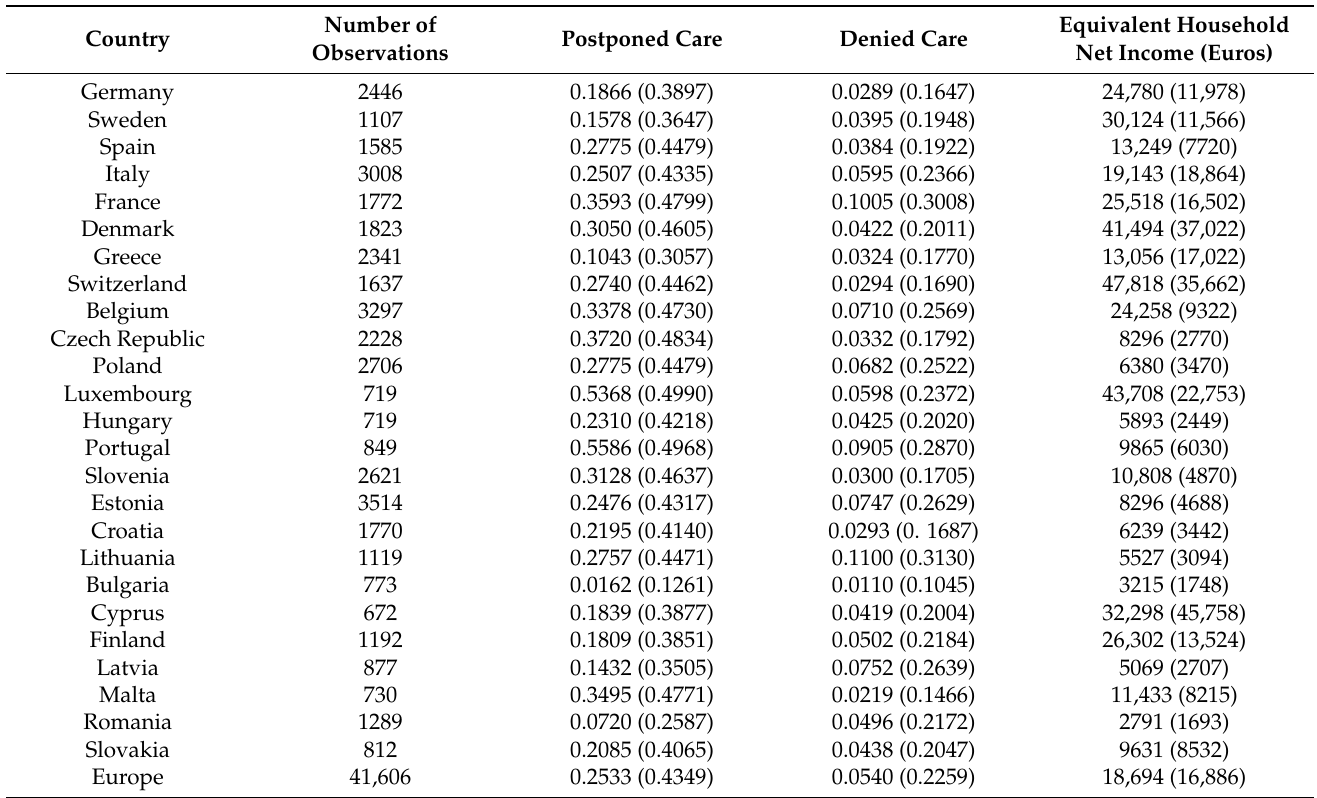
Table 2. Prevalence of unmet needs during the COVID-19 outbreak, by country, 2020. (Mean (Std.Dev.)). Number Country